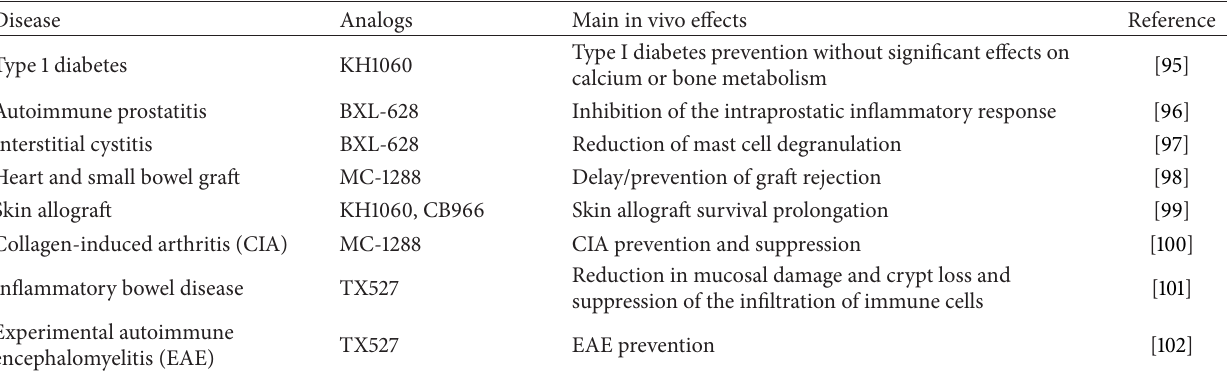
Table 2: In vivo effect of some VDR agonists. Vitamin D analogs suppress inflammatory mediators and processes resulting in disease